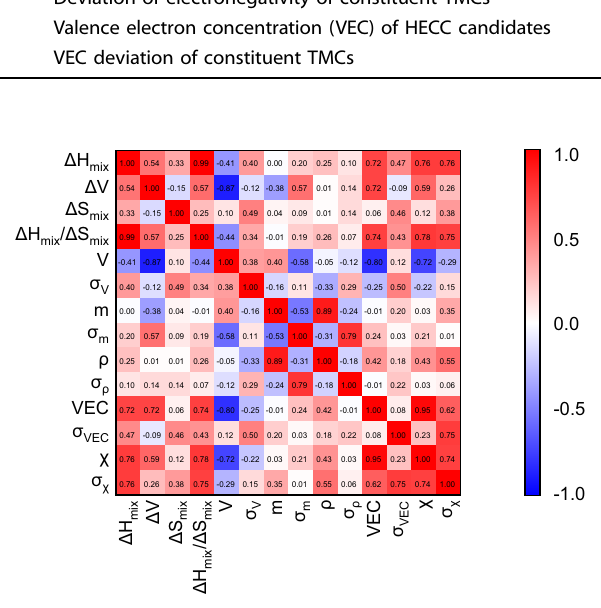
Fig. 1 Feature selection for ML models. Pearson correlation of input features is calculated by Eq.